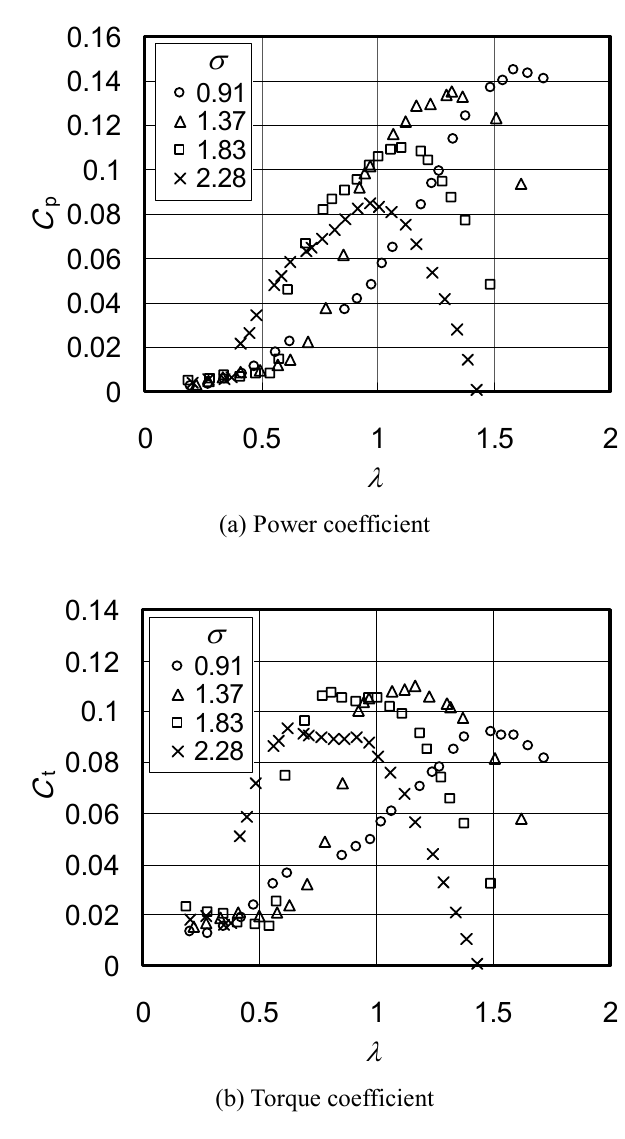
Fig. 4 Effect of solidity of rotor on turbine characteristics ( V = 9.0 m/s, α =